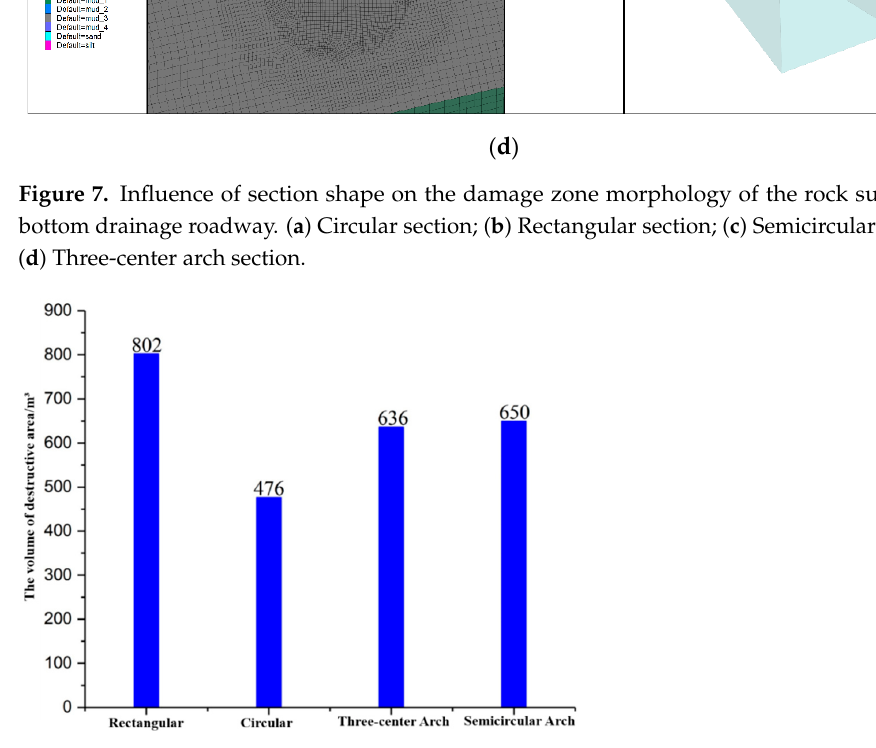
Figure 7. Influence of section shape on the damage zone morphology of the rock surrounding a bottom drainage roadway. ( a ) Circular section; ( b ) Rectangular section; ( c ) Semicircular arch sec- tion; ( d ) Three-center arch section.